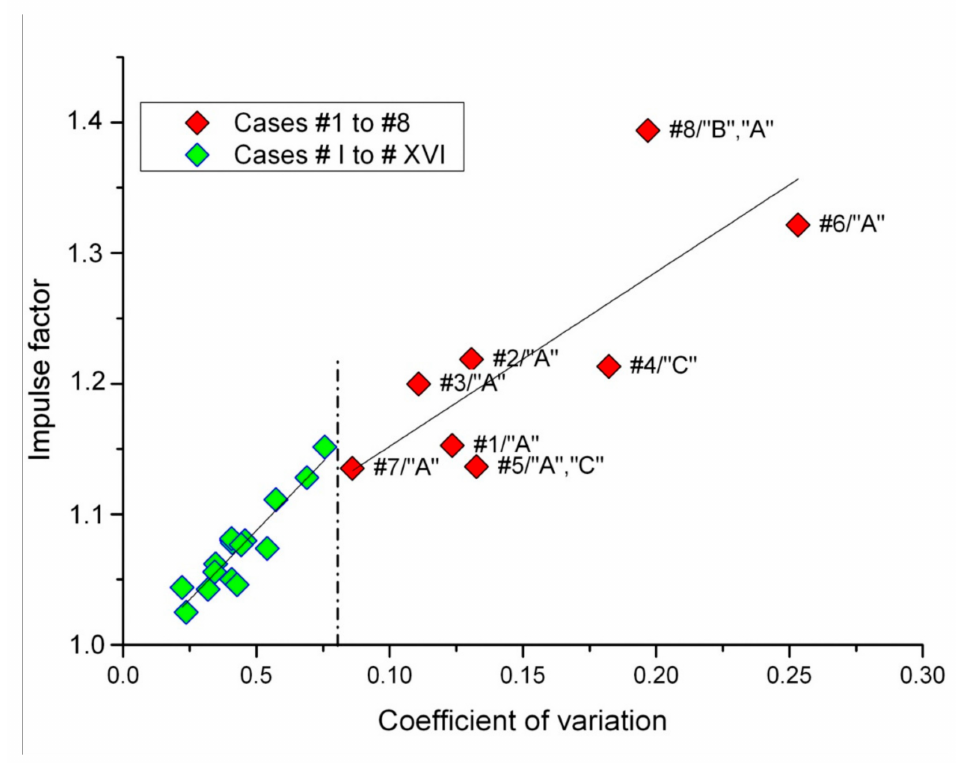
Figure 21. Empirical correlation between the diagnostic factors of the tested large-scale bearing